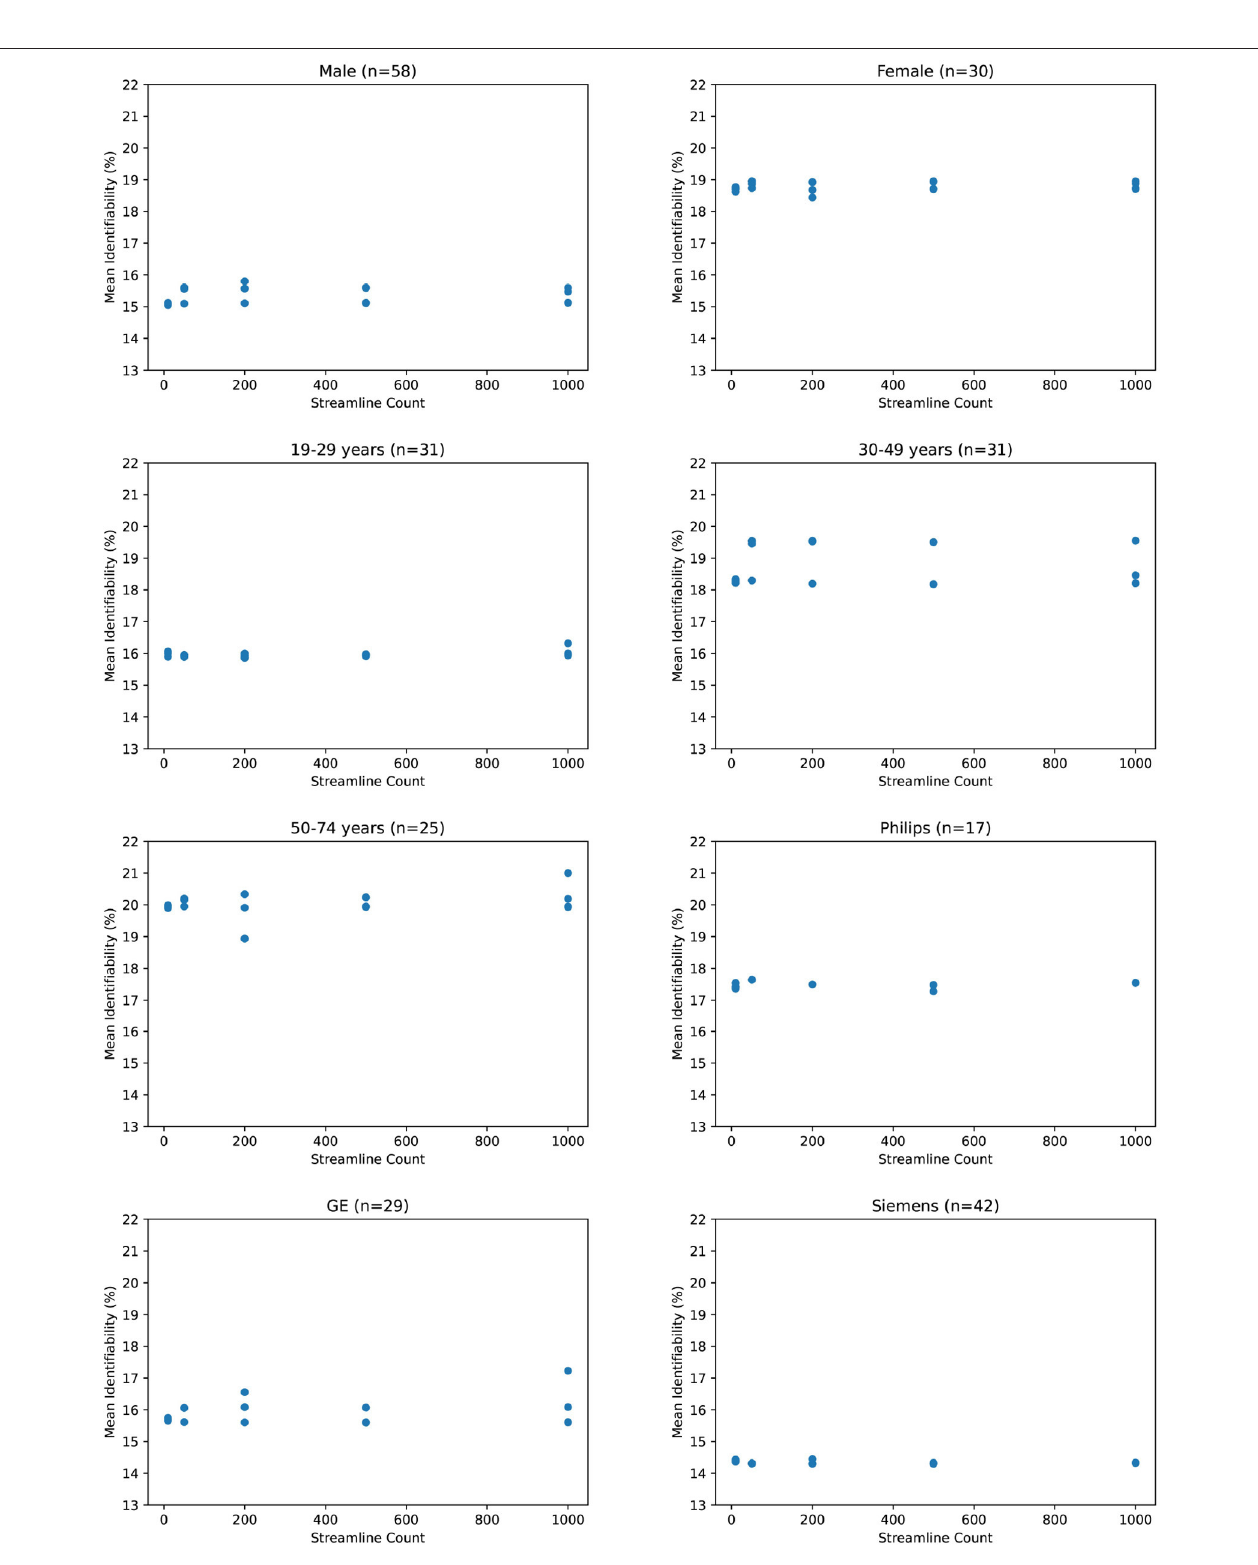
FIGURE 4 | Mean identifiability by category ( q = 4 random seeds per streamline count, k = 20 subset size, r = 10 repetitions).